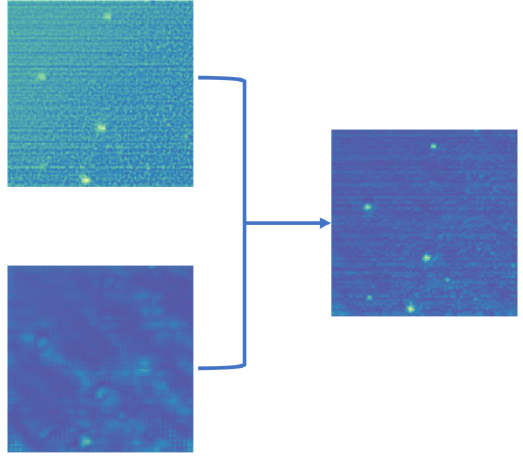
Figure 7. Expected effect of a skip connection.